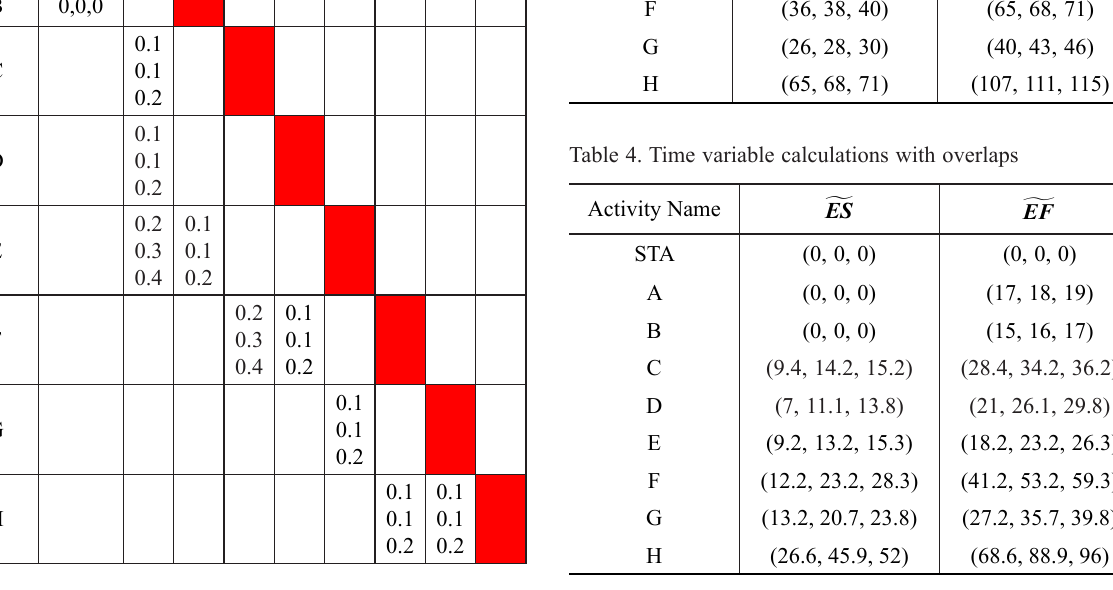
Fig. 7. Matrix C – Time factor relationships for the ji